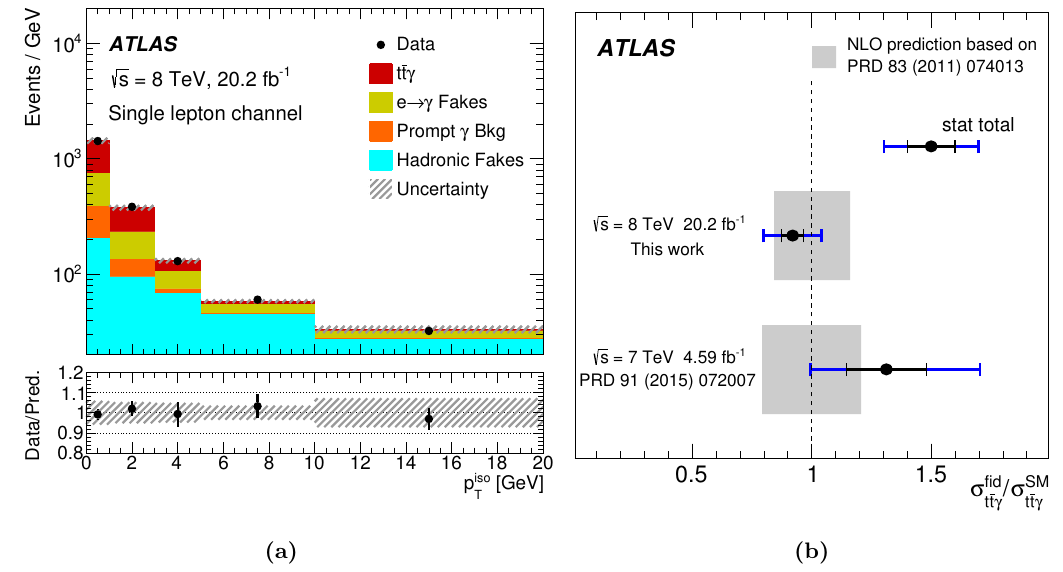
Figure 3. (a) Post-(cid:12)t track isolation distribution for the inclusive cross-section measurement. The last bin includes the over(cid:13)ow. The uncertainty band includes all uncertainties. (b) Summary of (cid:12)ducial measurements of t (cid:22) t(cid:13) production in pp collisions at 7 TeV [8] and 8 TeV, normalised to the expected cross section, calculated at NLO accuracy